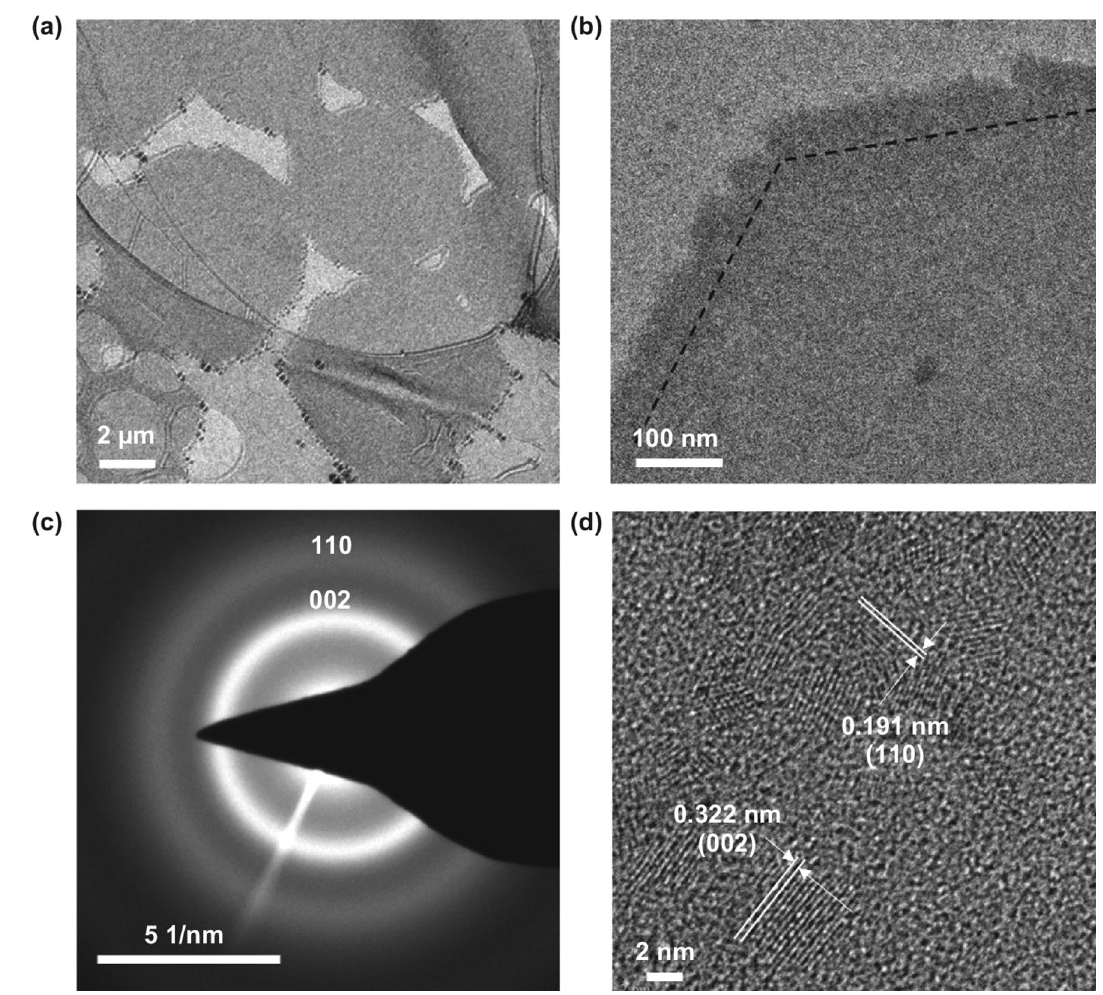
Figure 2 Structural characterization of 2.27-nm La 2 O 3 @NP-NS. a TEM image of hexagonal La 2 O 3 @NP-NS on a holy carbon TEM grid. b TEM image taken from a corner of a large La 2 O 3 @NP-NS. c SAED pattern of La 2 O 3 @NP-NS. d HRTEM image of La 2 O 3